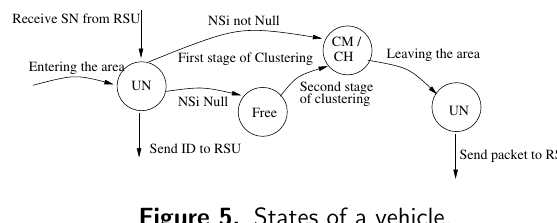
Figure 5. States of a